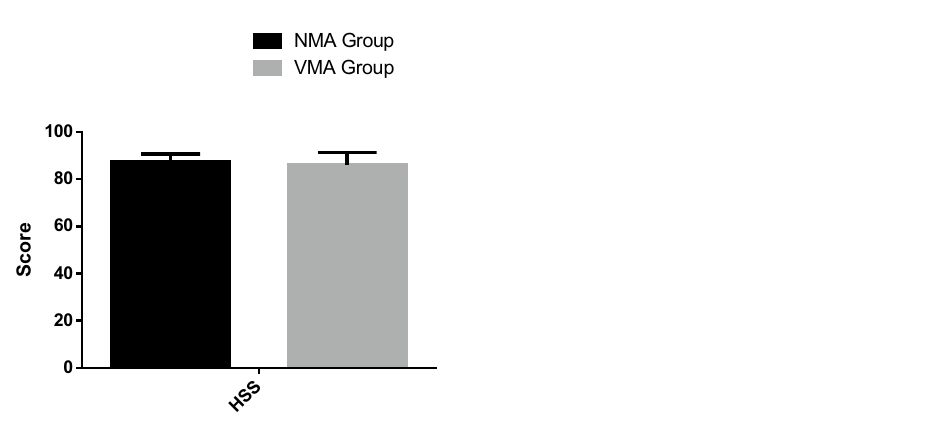
Figure 4. The difference of HSS score between the two groups after